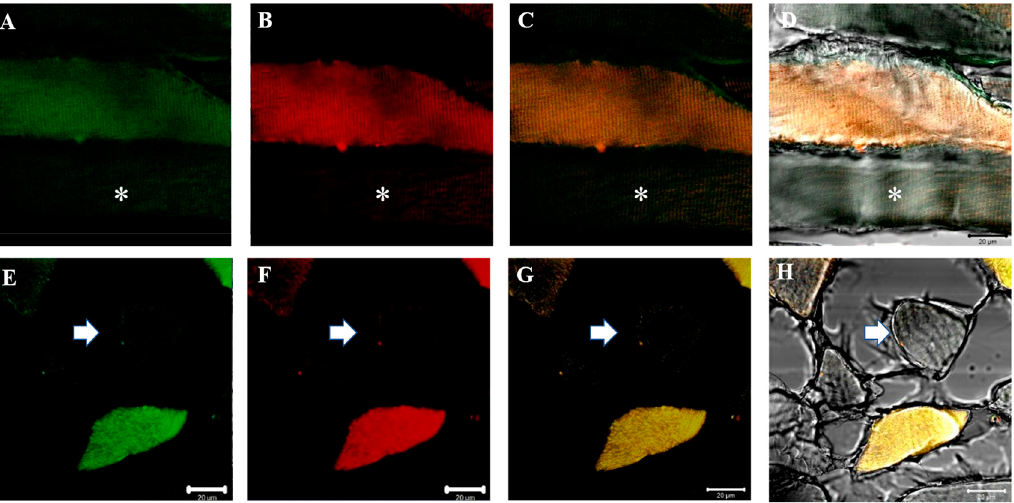
Figure 2. Compound panel of double immunofluorescence reaction between alpha-SG (green chan- nel) and beta-SG (red channel) ( A – D ) and between gamma-SG and delta-SG ( E – H ) performed on sternocleidomastoid of low-ranking baboons. Results show the presence of negative fibers for both alpha- and beta-SGs ( A – D , asterisk) and for both gamma- and delta-SGs ( E – H , arrow). The trans- mitted light shows the negative fibers ( D , H ). Positive and negative fibers are in the same microscopic field. The yellow fluorescence arises from the merge between green and red fluorescence. The same data have been found for all the SG isoforms.